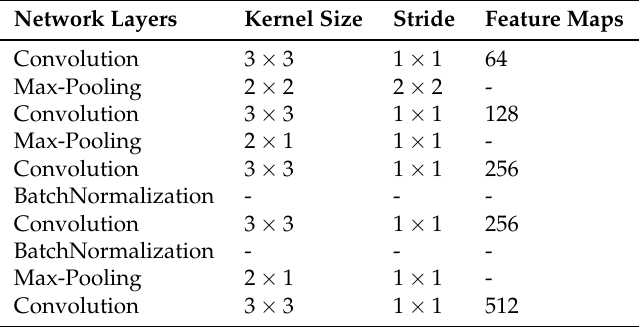
Table 2. Convolutional network layers of the proposed model and their corresponding parameter values for an input image size 32 × 128 × 1.